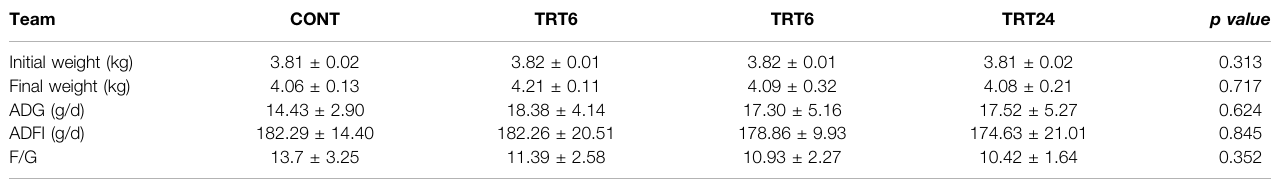
TABLE 3| Effects ofalfalfa-mixed silagefermentationmaterial(AMSFM) on growthperformanceofmeat geese. Controlgeese (CONT) werefedabasaldiet, whereasTRT6, TRT12, and TRT24 were fed a basal diet supplemented with 6, 12, or 24% AMSFM, respectively. Team